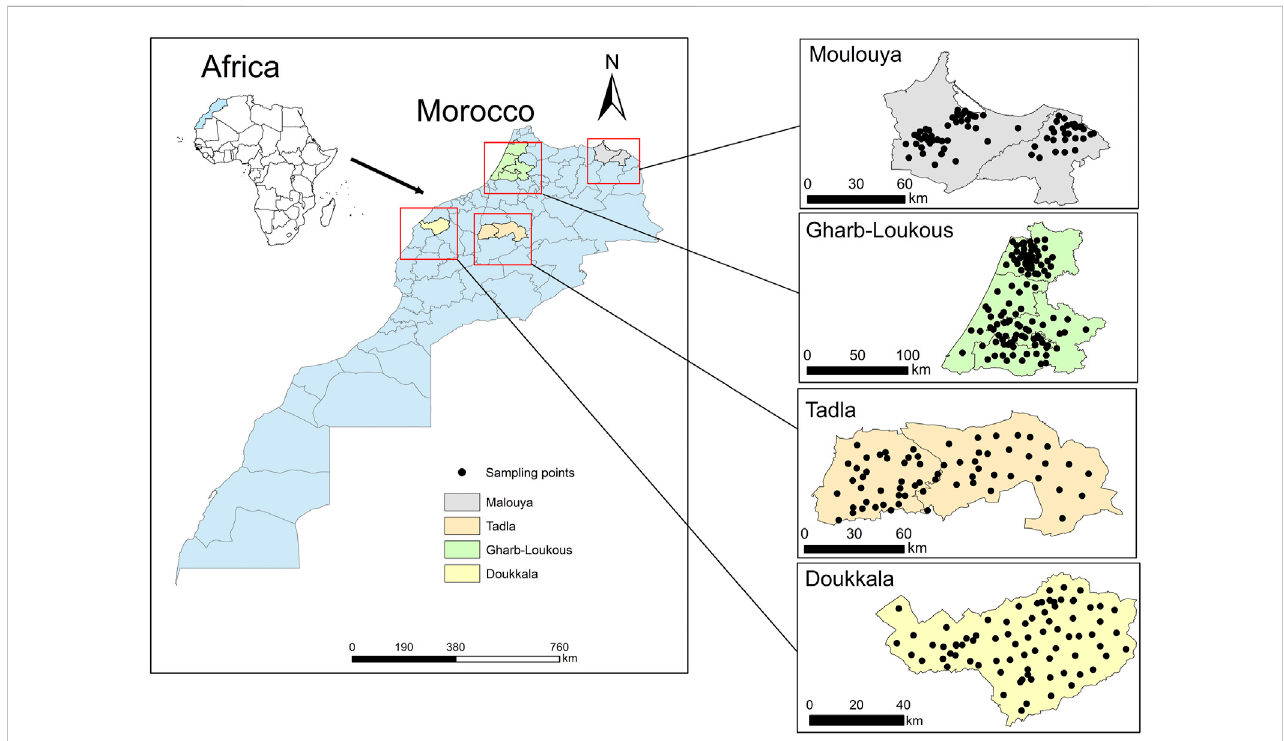
FIGURE 1 Location of study areas and sampling regions in